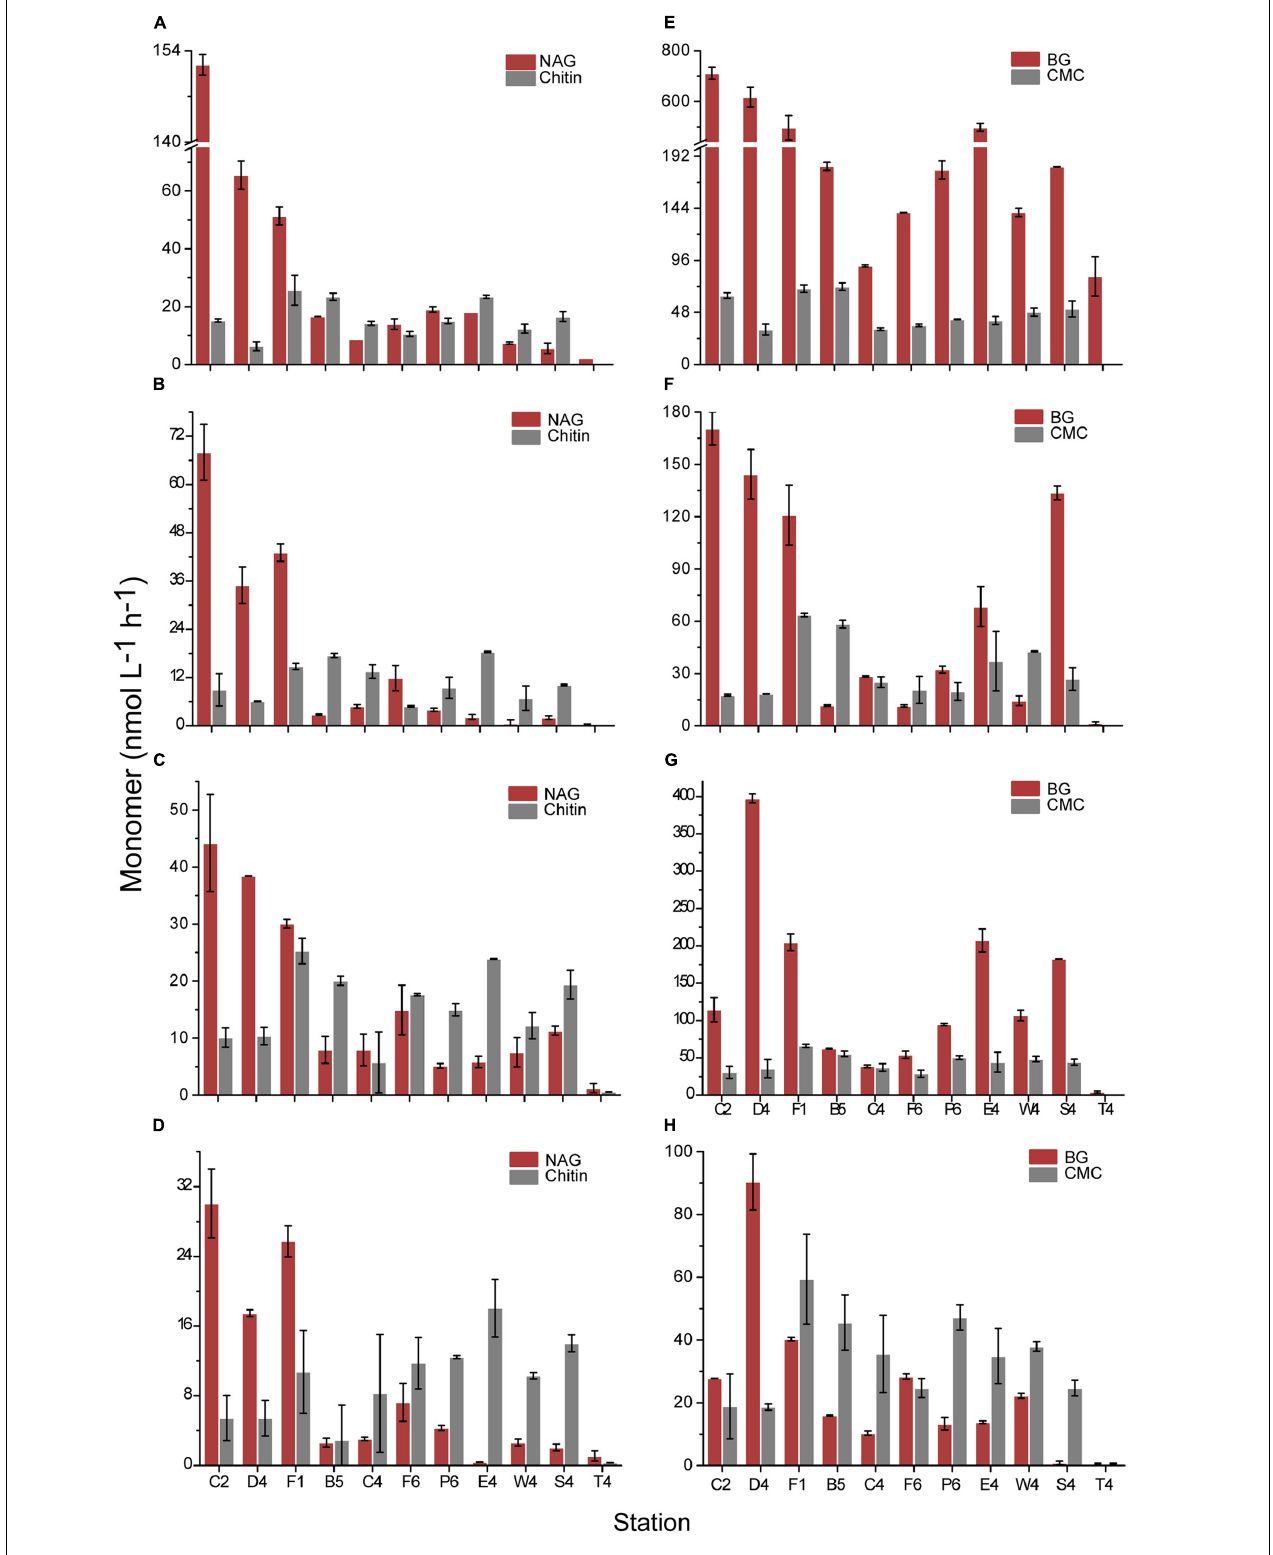
FIGURE 5 | Comparison of hydrolysis rates of polymer and corresponding monomer. (A,E) The unfiltered waters at 35 ◦ C. (B,F) The 0.22- µ m filtered waters at 35 ◦ C. (C,G) The unfiltered waters at 25 ◦ C. (D,H) The 0.22- µ m filtered waters at 25 ◦ C. (A–D) Present NAG and chitin. (E–H) Present BG and CMC.